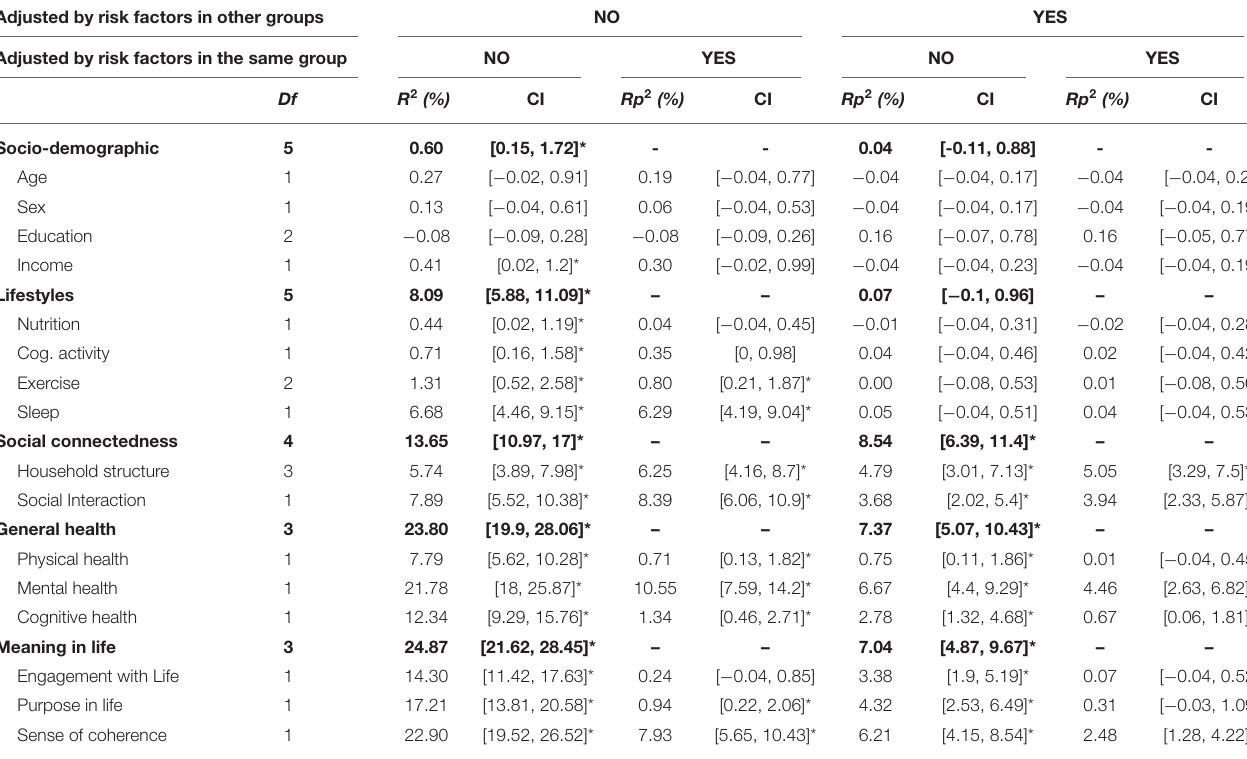
TABLE 2 | Explanatory contribution for each risk factor in regression models with increasing number of adjusting factors. Adjusted by risk factors in other groups NO YES Adjusted by risk factors in the same group